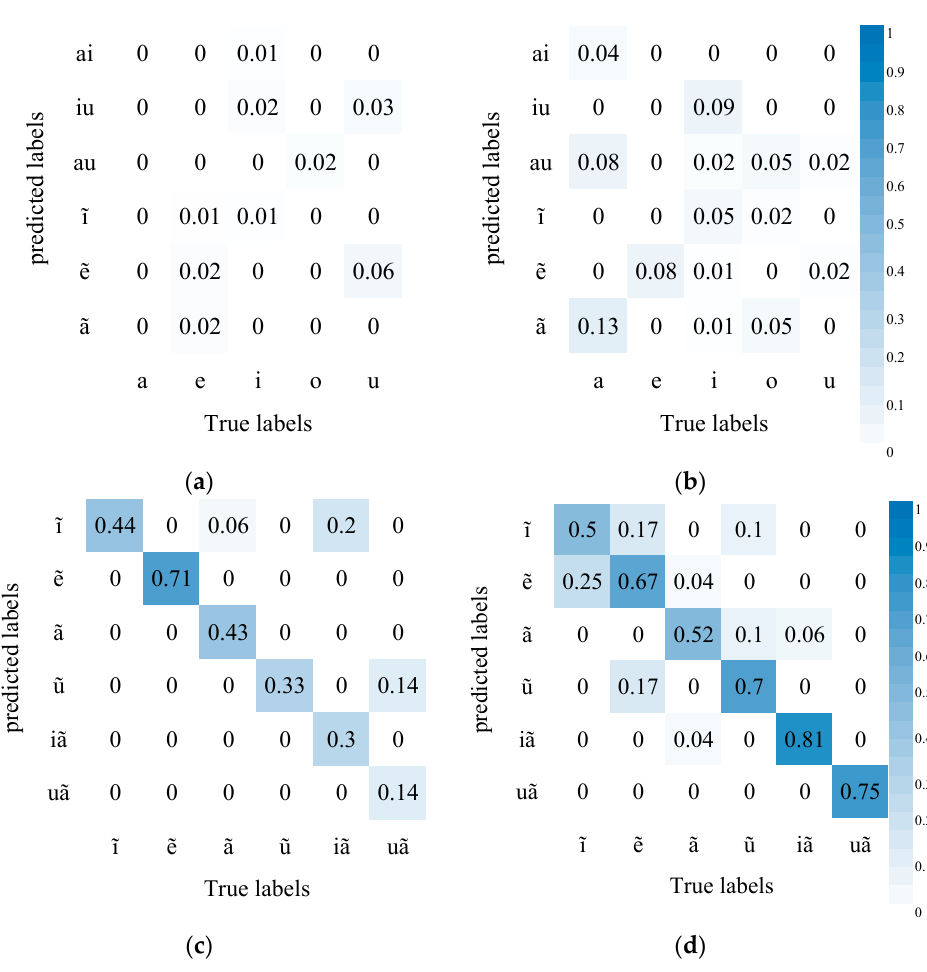
Table 6. With the training set’s speakers excluded from the test set, the CER of audio, video, and different approaches of fusion modeling to recognize different quantity of sentences.